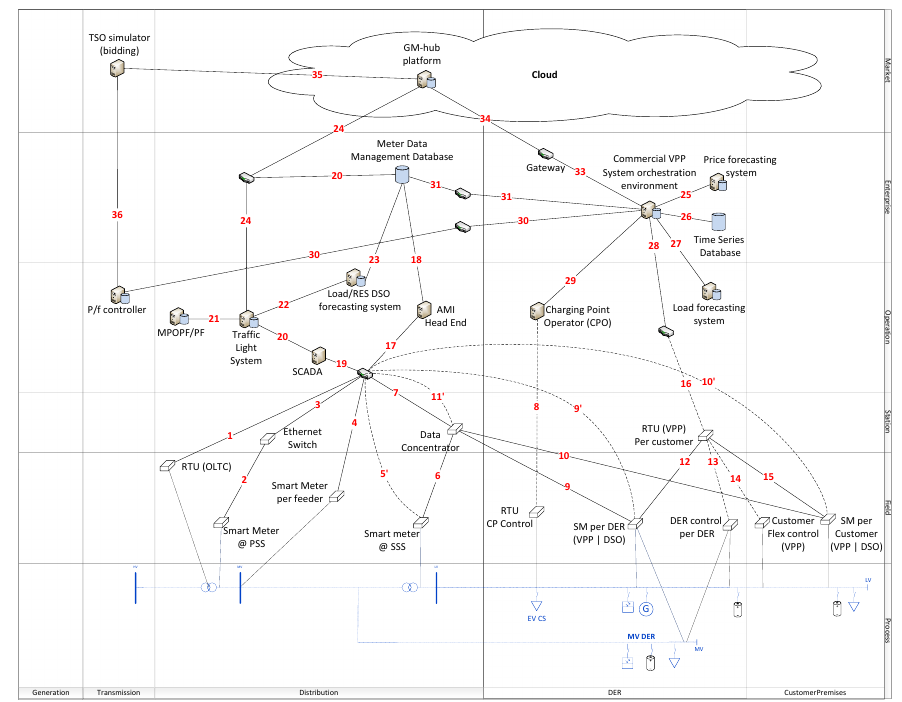
Figure 2. Smart Grid Architecture Model (SGAM) representation of the scenario analyzed in the paper (Large Customer Commercial Virtual Power Plant